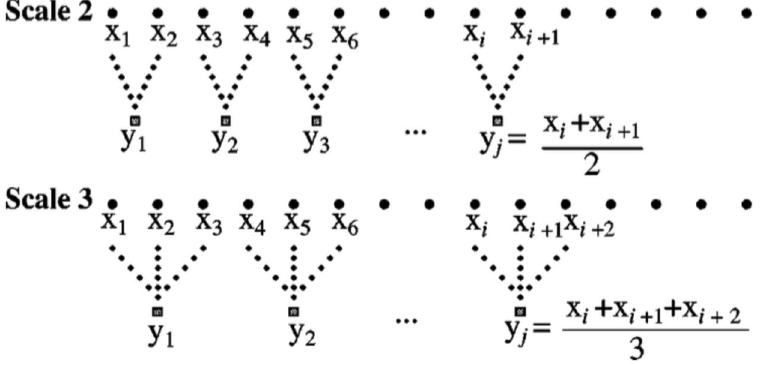
Figure 3. The coarse-graining procedure introduced by Costa et al . 27 is illustrated. For powers of 2, the resulting scaled time series are identical to Haar wavelet transform approximations.